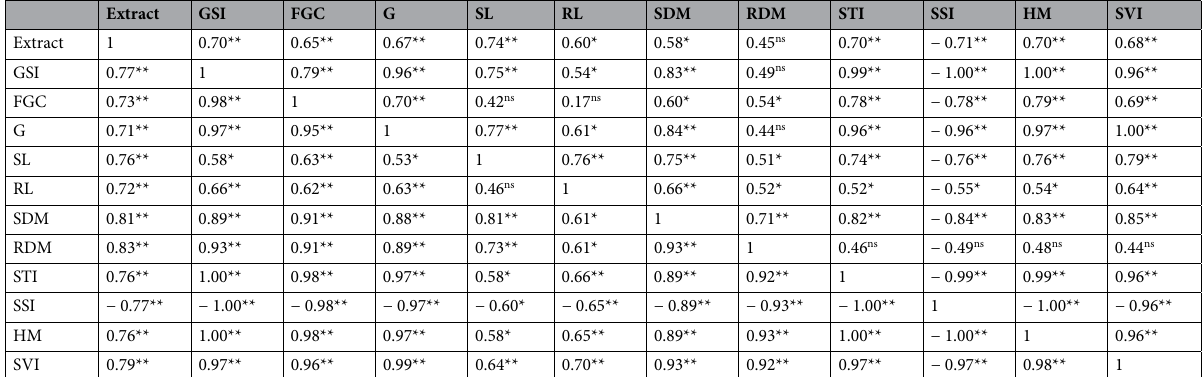
Table 4. Pearson correlation for 12 variables, evaluated in the germination season in two rice cultivars, BRS Querência (above diagonal) and Brilhante (below diagonal), in response to the conditioning of the seeds in carrot extract and the low temperature in germination. ** Significant at 1% probability of error; * significant at 5% probability of error; ns not